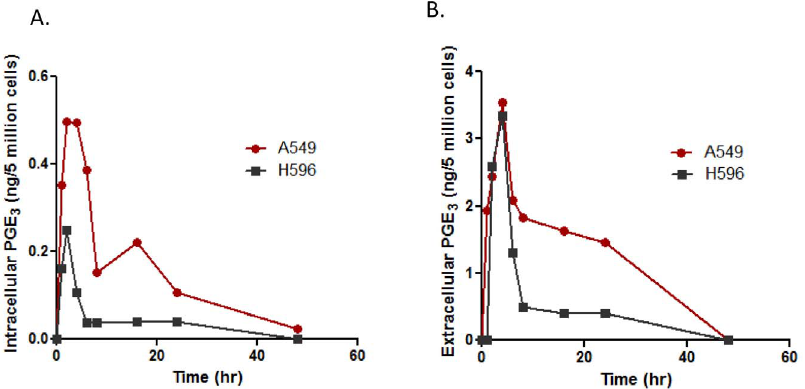
Figure 5. Intracellular and extracellular PGE 3 in A549 and H596 cells. (A) Cells were treated with EPA for different times as indicated and intact cells were collected by trypsinization and subjected to analysis by LC-MS/MS. Intracellular levels of PGE 3 in A549 cells were at least twofold higher than those in H596 cells. (B) Cell culture media were collected at different times as indicated and subjected to solid-phase extraction. Extracellular levels of PGE 3 were then analyzed by LC-MS/MS. Data are representative of two separated